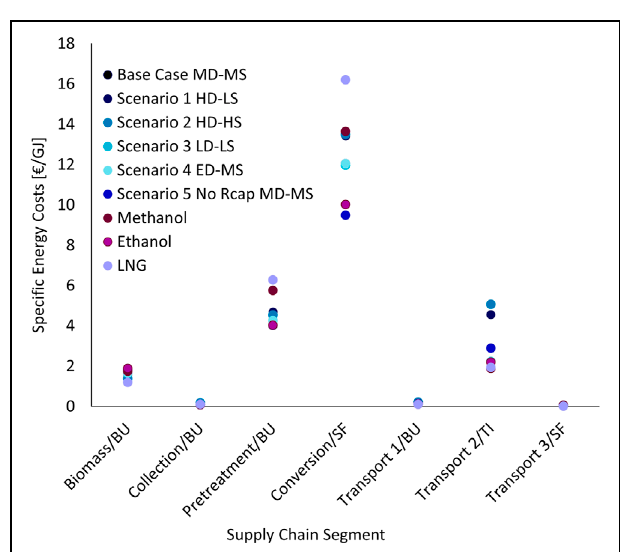
FIGURE 7 | Specific emissions per supply chain